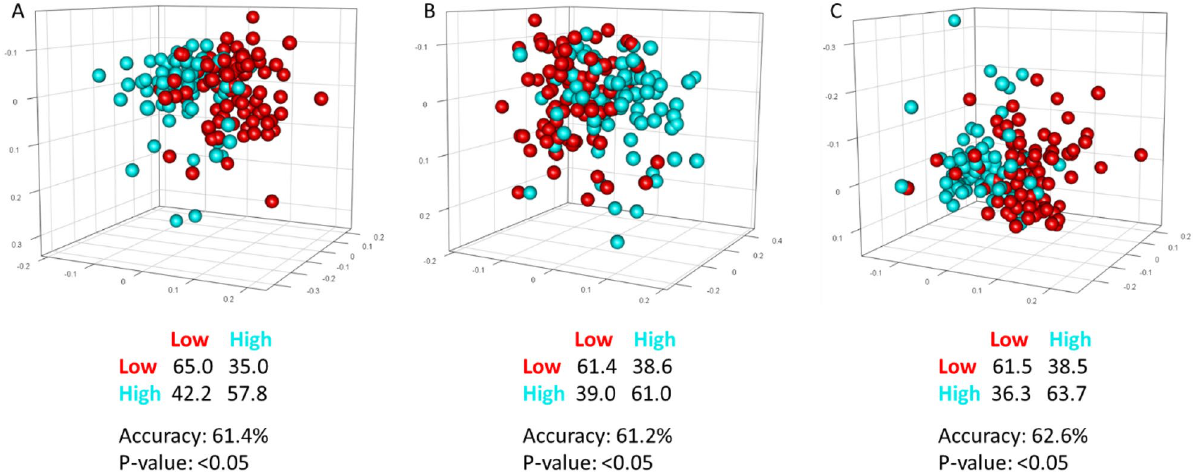
Figure 2. OPLS-DA score plot and confusion matrix for the comparison of low (red spheres) and high (cyan spheres) mammographic density breast cancer patients. The results are reported for the three kind of NMR spectra acquired: ( A ) NOESY, for low and high molecular mass molecules; ( B ) CPMG, for low molecular mass molecules; ( C ) Diffusion, for high molecular mass molecules. (EPIC Florence, low- vs high-MBD BC case–case